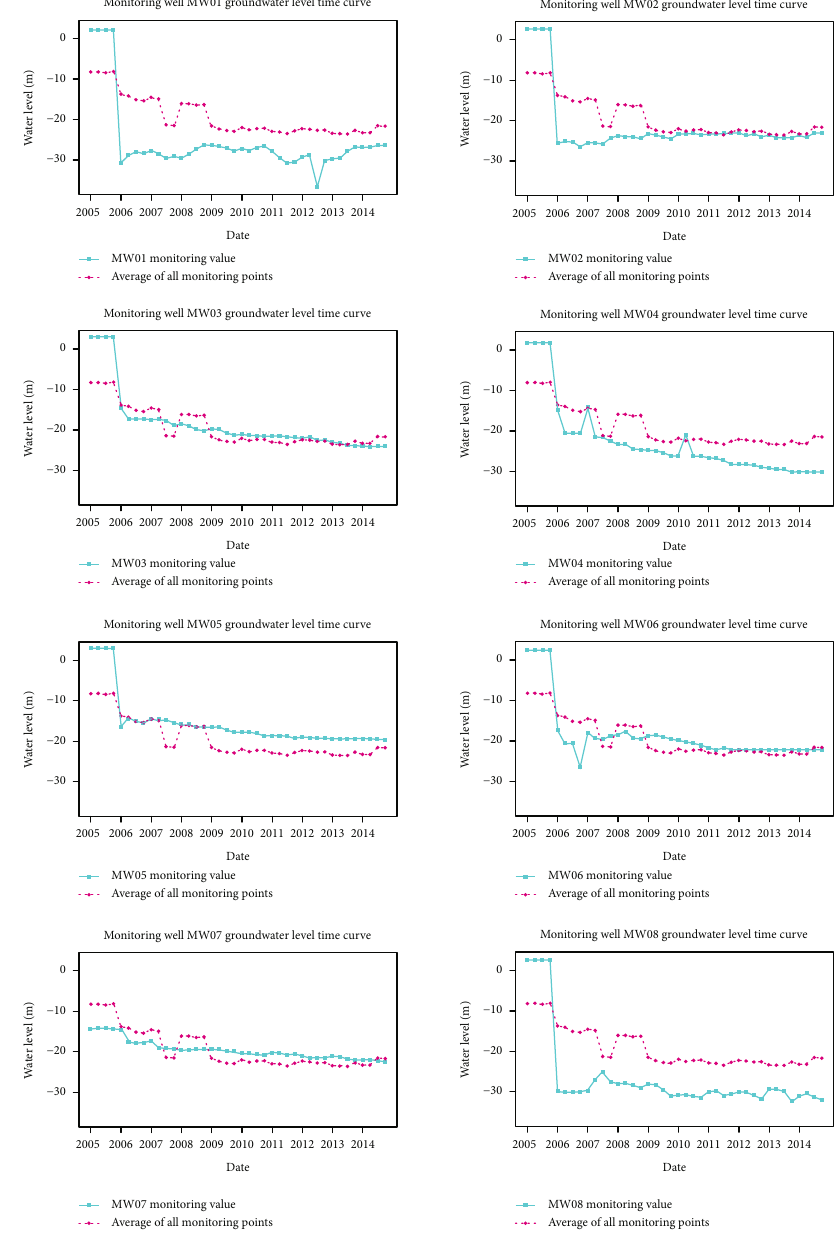
Figure 2: Main monitoring well groundwater level